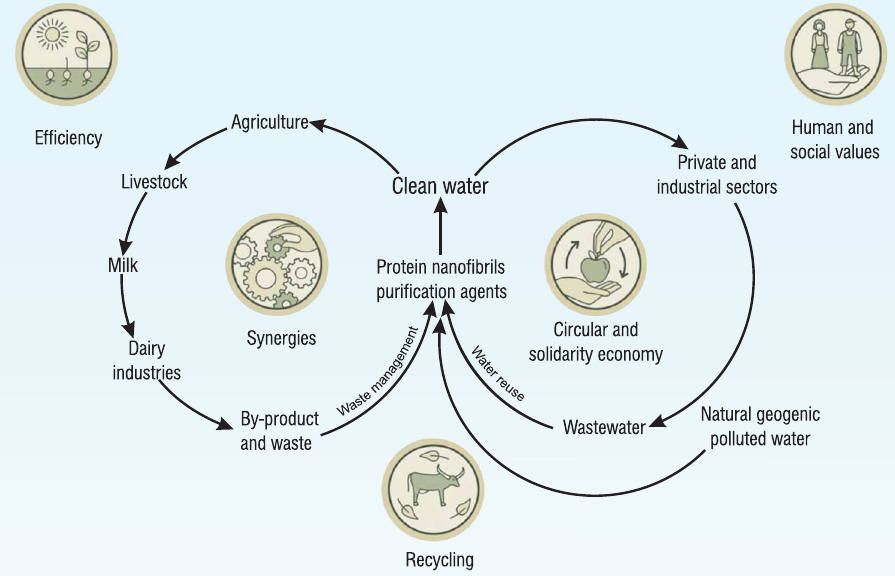
Fig. 5 Role of protein nano fi brils in circular economy and their impact on Agroecology. Individual visual elements/medallions of agroecology reproduced with permission from ref. 87 , Food and Agriculture Organization of the United